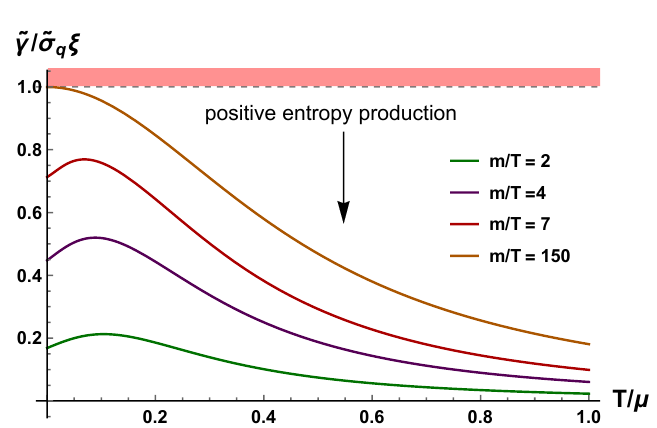
Figure 9 . The combination ~ (cid:13) 2 =(cid:27) q (cid:24) as a function of T=(cid:22) for various values of m=T . This (cid:12)gure has to be compared with (cid:12)gure 4 of [24].